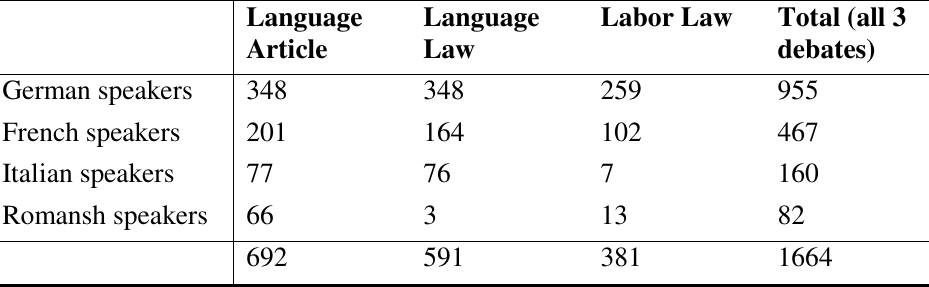
Table 8: Speeches by Language Groups